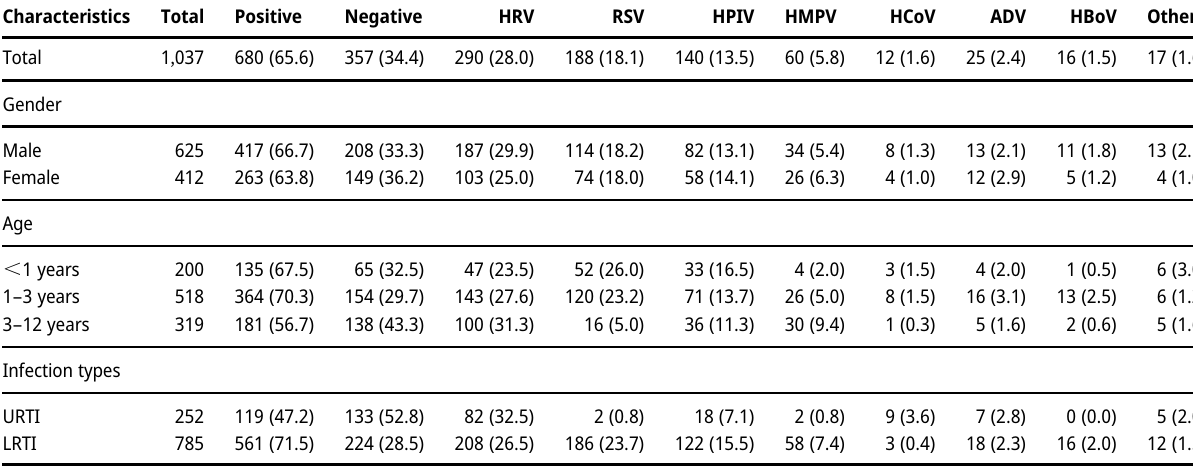
Table  : The distribution of common respiratory viruses in  ,  children with RTIs.